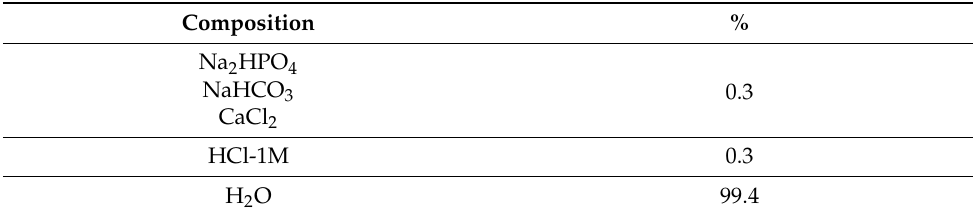
Table 1. Percentage components of artificial saliva.